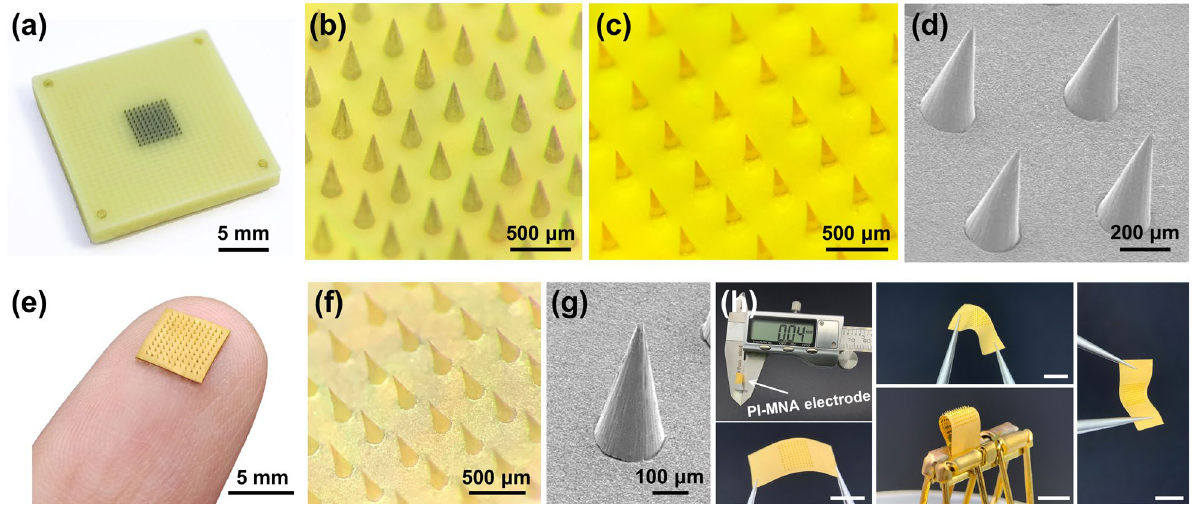
Fig. 2 a Photograph and b micrograph of the assembled rigid master mold. c Optical and d SEM micrographs of polyimide microneedles after micromolding. e Photograph, f optical and g SEM micrographs of the PI-MNA electrode after Ti/Au deposition. h Thickness and distortion characterization of the PI-MNA electrodes (scale bar: 5 mm). For the convenience of the tests, redundant areas were reserved at opposite sides of the